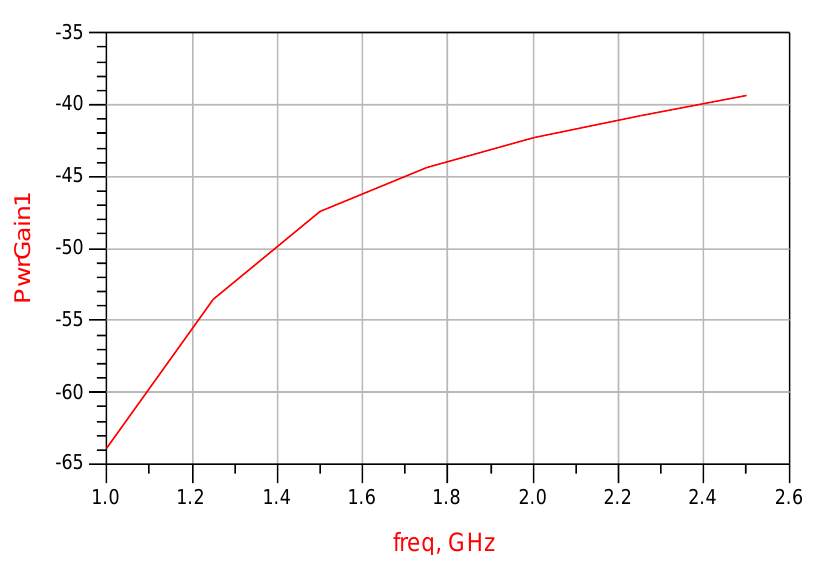
Figure 9. Maximum Circuit chart.